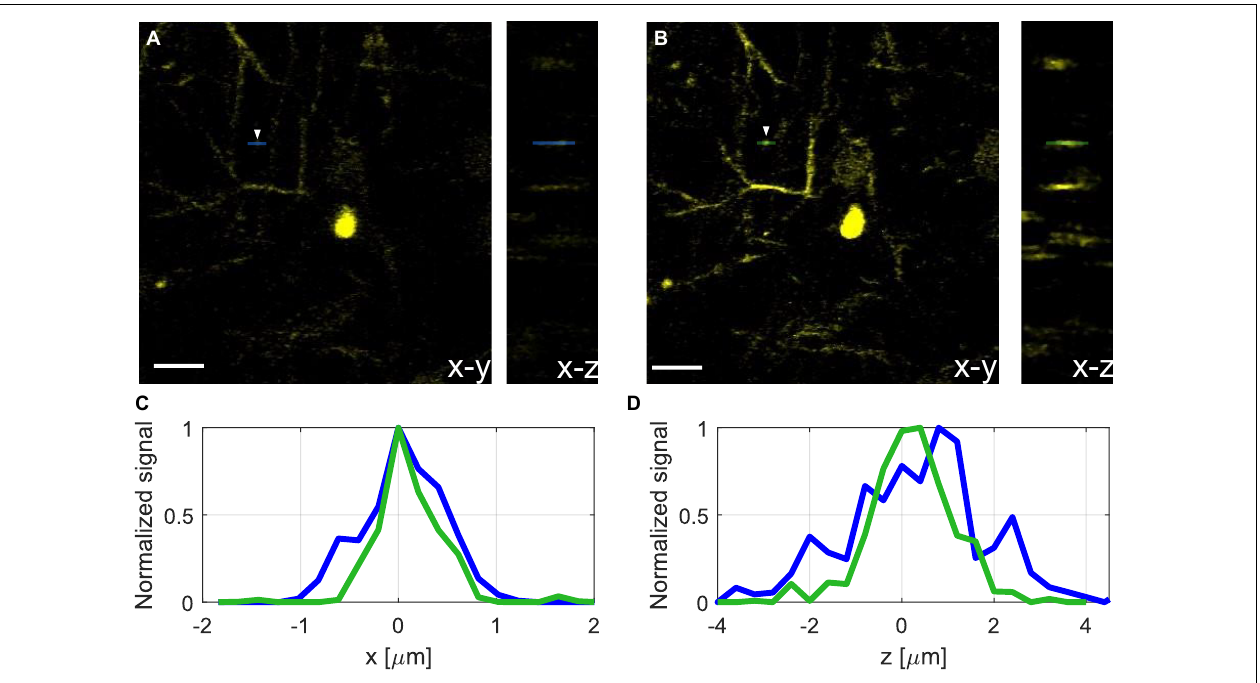
FIGURE 5 | Projection of neurons and dendrites at 600 µ m depth before (A) and after (B) AO correction, scale bar, 10 µ m. (C) Normalized lateral line profiles of a dendritic spine (see white arrow) before (blue), and after (green) correction. (D) Normalized axial line profile of a dendrite before (blue), and after (green) correction.